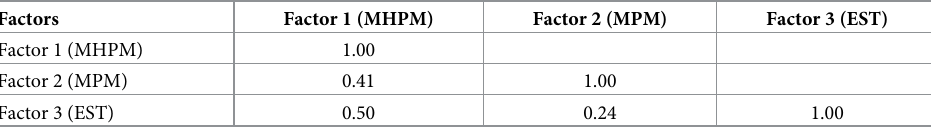
Table 4. Correlations among oblimin oblique normalized rotated common factors.